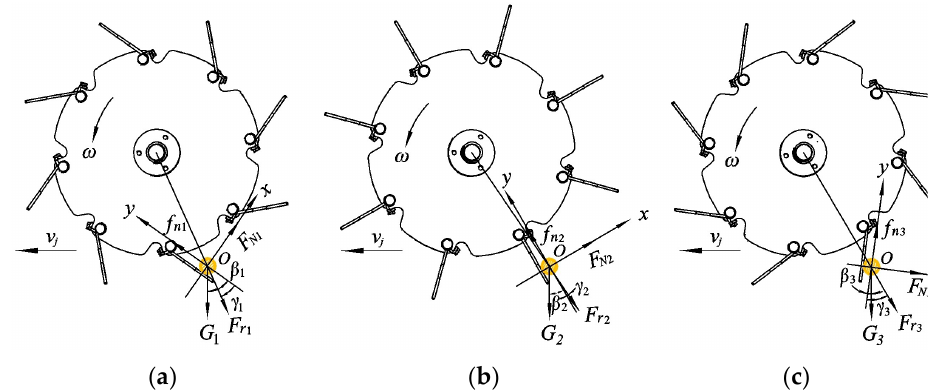
Figure 11. Force analysis of straw when spring teeth throw straw under three installation types. ( a ) Forward inclination; ( b ) Radial; ( c ) Backward inclination. Note: β 1 , β 2 and β 3 are the included angles between the gravity of maize straw G 1 , G 2 , G 3 , and the y -axis, °; F r1 , F r2 and F r3 are the centrifugal force of maize straw, N; γ 1 , γ 2 and γ 3 are the included angles between the centrifugal force of maize straw F r1 , F r2 , F r3 , and the y -axis, °.